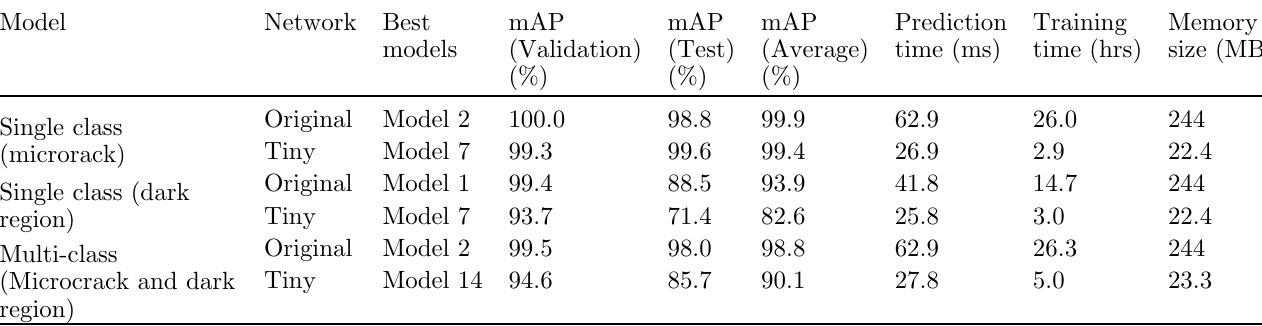
Table 2. Best single and multi-class models comparing original and tiny YOLOv4.